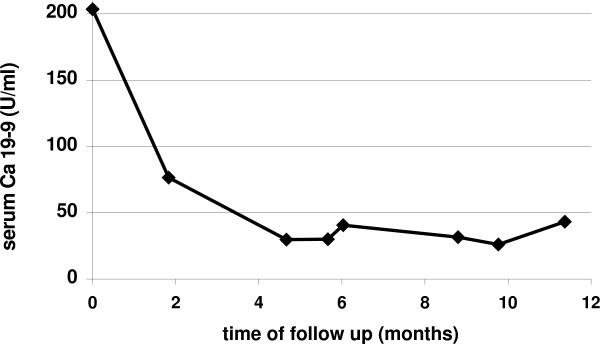
Kinetics of Ca 19-9 concentrations during chemotherapy. Quantification of Ca 19-9 serum concentrations by ELISA.